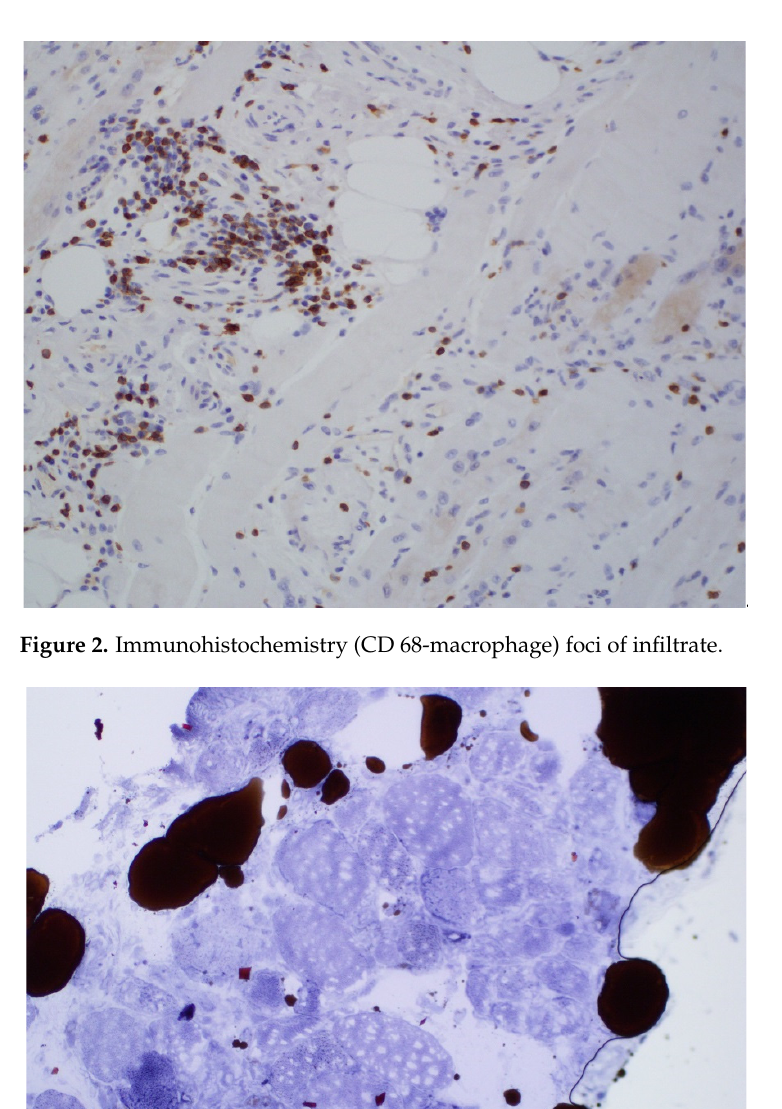
Figure 3. Sudan black stain: lipid droplets in scattered and intact myofiber (low power).